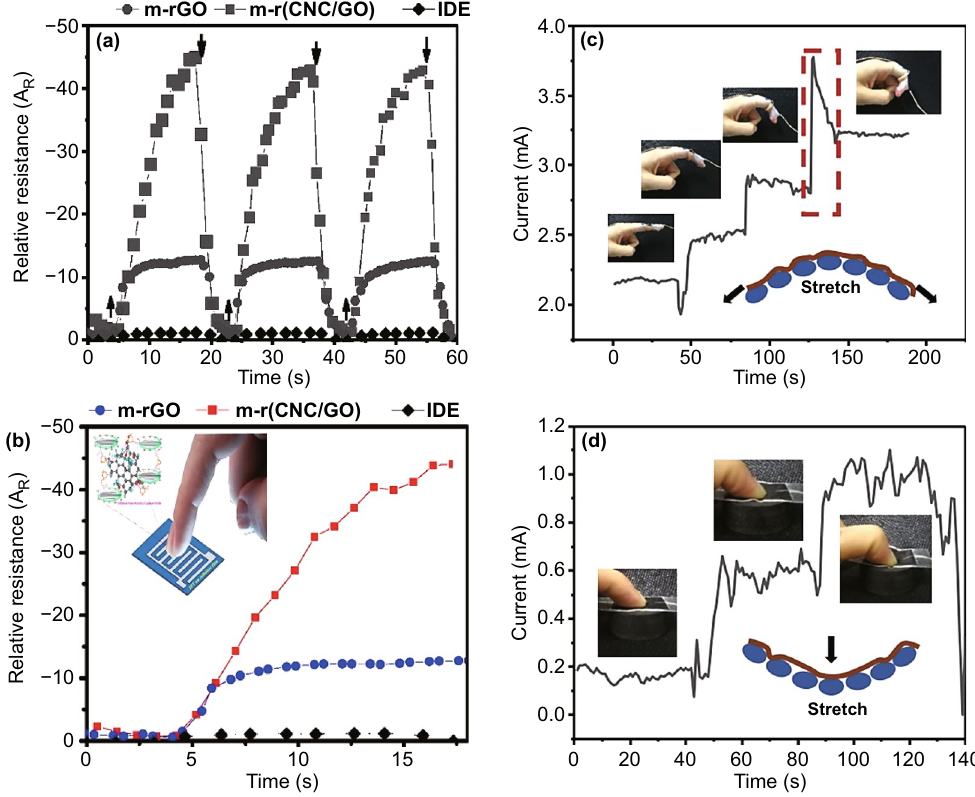
Fig. 25 a Proximity sensitivity of CNCs-rGO hybrid film at 0.2 mm human finger distance. Reproduced with permission from Ref. [146] Copy- right © 2014, WILEY ‐ VCH Verlag GmbH & Co. KGaA, Weinheim. b Tactile sensitivity of CNCs-rGO hybrid film. Reproduced with permis- sion from Ref. [164] Copyright © 2015, Society of Photo-Optical Instrumentation Engineers (SPIE). c , d Resistance change of CNFs-rGO strain sensor in monitoring human finger bending and pushing motions, respectively. Reproduced with permission from Ref. [130] Copyright © 2018, IOP Publishing